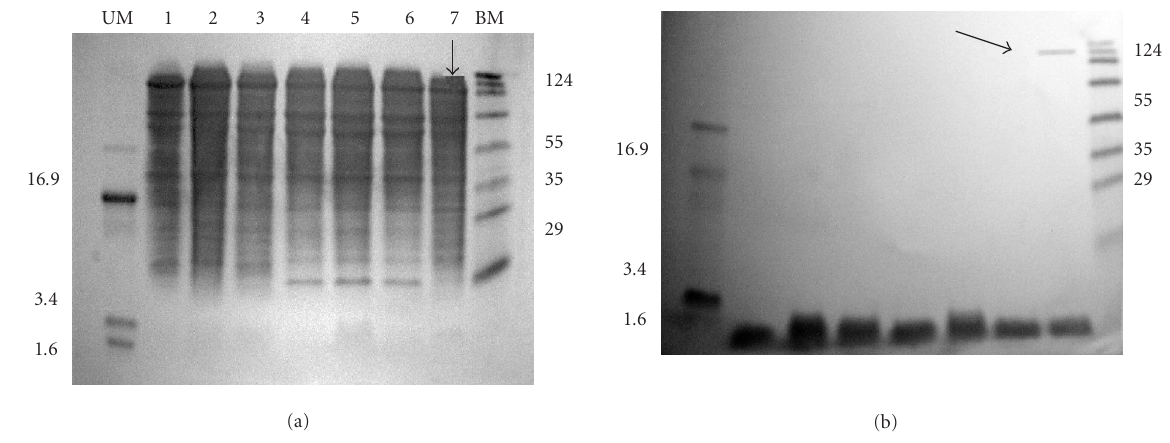
Figure 13. UM represents ultra-marker (peptides). BM represents broad-range marker (proteins). 1-2: P pastoris X-33 induced trans- formants (day 3). 3: uninduced P pastoris X-33 transformants (day 3). 4-5: P pastoris KM71 H induced transformants (days 5 and 6). 6: uninduced P pastoris KM 71H transformants (day 5). 7: P pastoris GS115/LacZ expression control. (a) SDS PAGE gel of time- course intracellular samples of transformed P pastoris (KM71H and X-33) and (b) Western blot of time-course intracellular samples of transformed P pastoris (KM 71H and X-33).